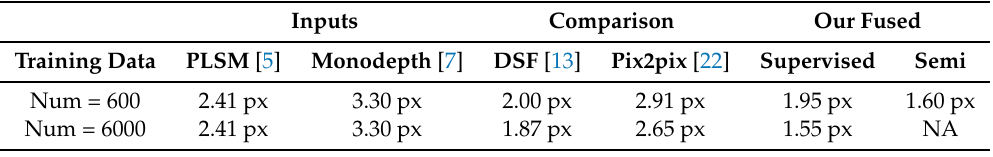
Table 6. Mean absolute disparity error of stereo-monocular fusion on Scene Flow (1460 test samples).